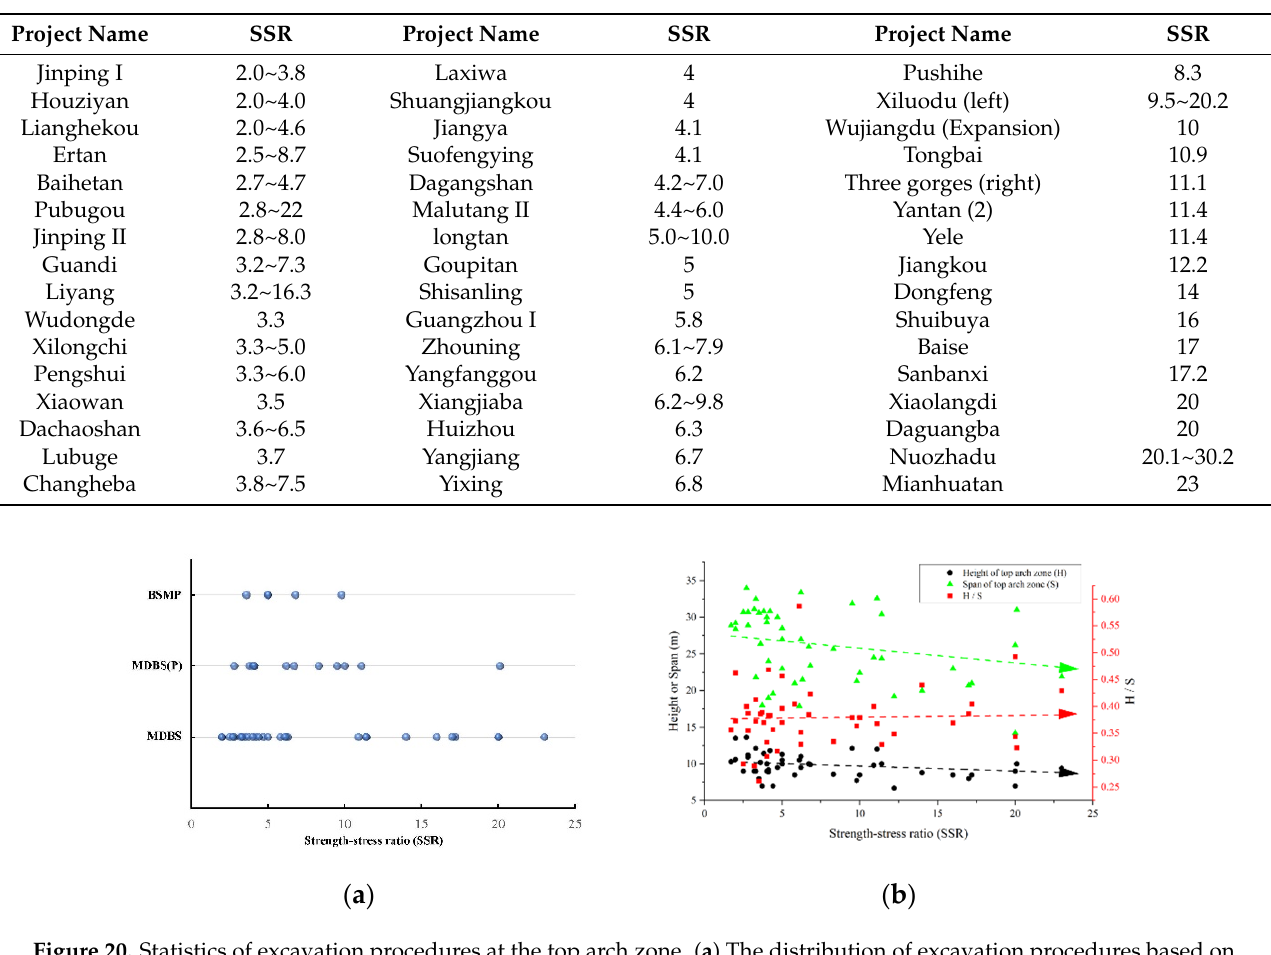
and MDBS(P) are more suitable under the low strength–stress ratio. Figure 20b shows the relationship between the excavation height (H), excavation span (S), H/S and SSR. With the increasement of SSR, the excavation height (H) and span (S) show a certain trend of slight reduction while H/S is relatively dispersive around 0.38. Table 3. Summary of SSR in forty-eight underground powerhouses.